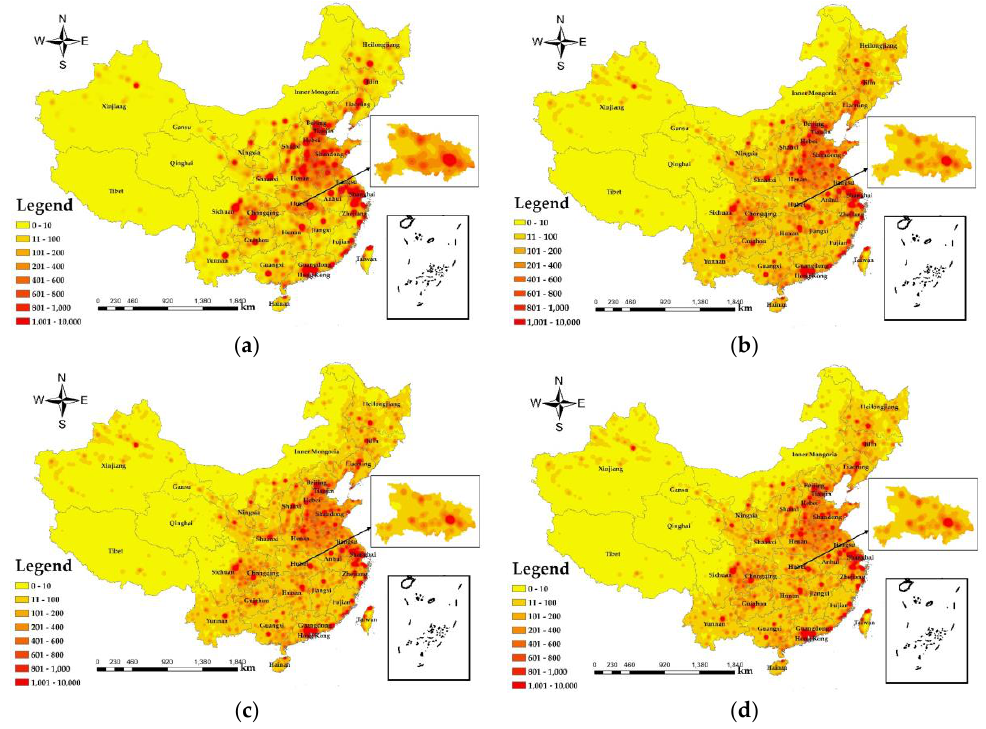
Figure 5. Population density distribution map based on LBS data. ( a ) 25 December 2019; ( b ) 11 January